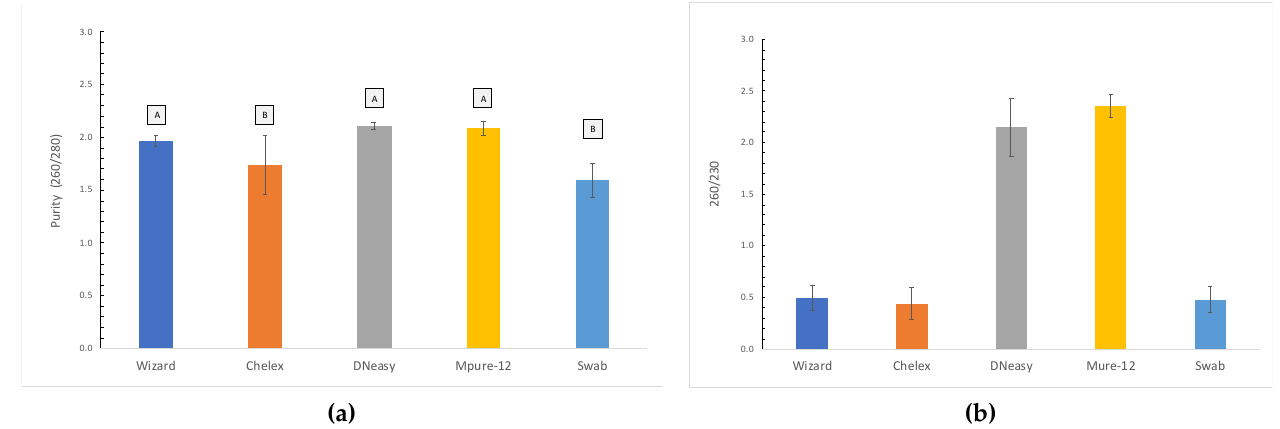
Figure 4. ( a ) Purity (260/280) of the tested DNA extraction methods. Data are presented as mean ± SD of samples per method. Non-identical subscript letters (A, B) indicate a statistically significant difference ( p < 0.05). ( b ) Ratio 260/230 of the tested DNA extraction methods. Data are presented as mean ± SD of samples per method.